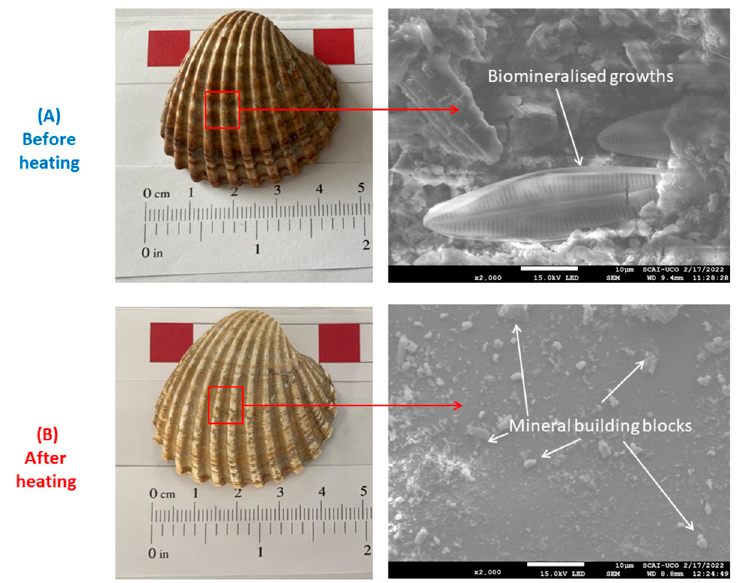
Figure 2. Image before ( A ) and after ( B ) heat treatment of Acanthocardia tuberculata shell and SEM observations. Biomineralised growths.